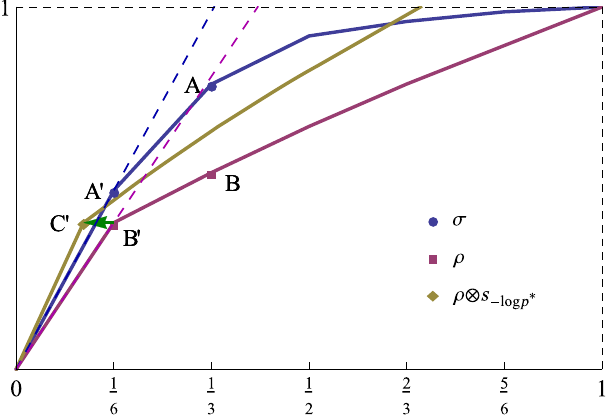
FIG. 3. We plot the curves of ρ , σ , and ρ compressed by p (cid:3) (with respect to the x axis). The points A and B at which the vertical ratio between the curves of ρ and σ is maximum (which sets l 1 and p (cid:3) ) and the sharp states I ∞ ð ρ Þ and I ∞ ð σ Þ are also shown as dashed lines. Given that for sharp states all bounds are saturated, the appropriate maximum vertical and horizontal ratios coincide, and are η 1 = ζ 1 , the ratio of the heights of B 0 and A 0 . But this ratio is, by definition, bigger than or equal to p (cid:3) , the ratio between A and B. This means that if the curve of ρ is compressed by p (cid:3) , the point B 0 is mapped to C just above or touching the curve of σ , proving the upper bound of Eq.